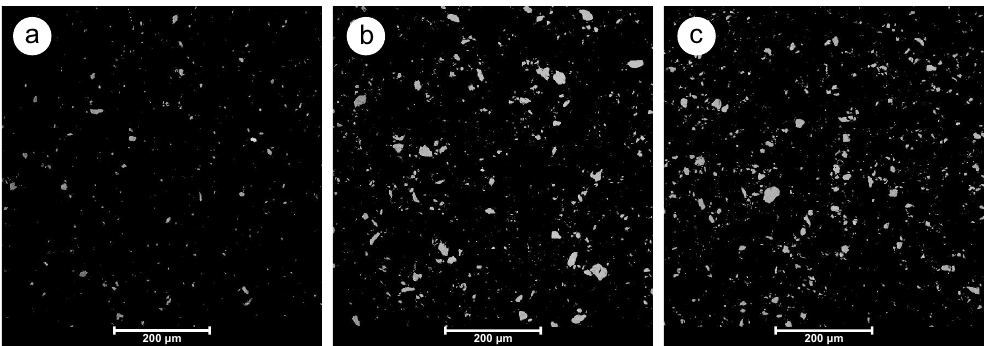
Figure 2. SEM images of the manufactured EP/ HNTs cross-sections: ( a ) EP/2.5HNT, ( b ) EP/6.5HNT, and ( c )